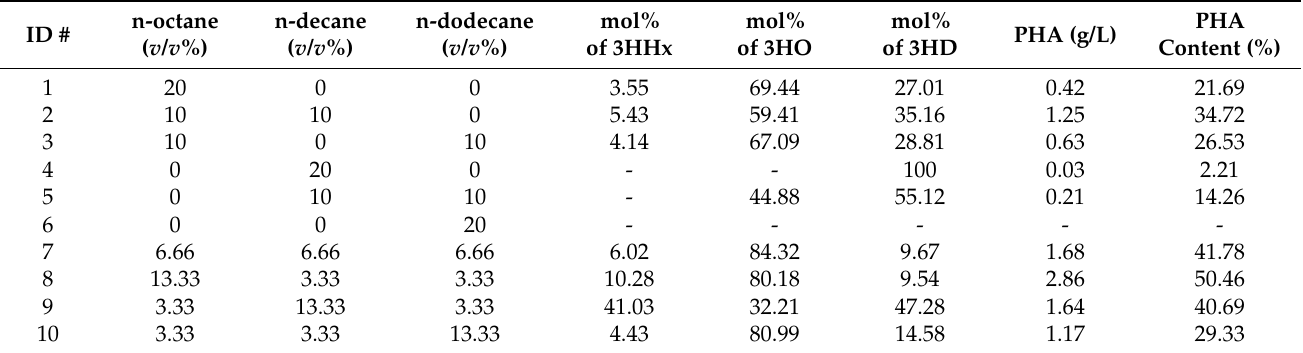
Table 2. Monomer composition of 10 conditions by mixture